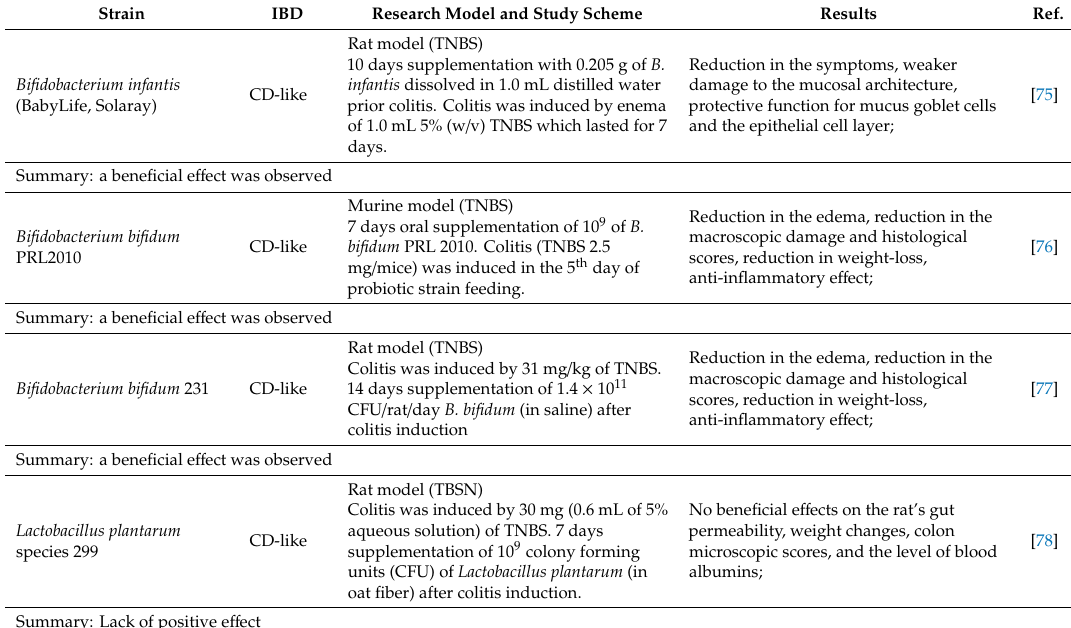
Table 2. The e ff ectiveness of probiotics in the treatment of IBD.